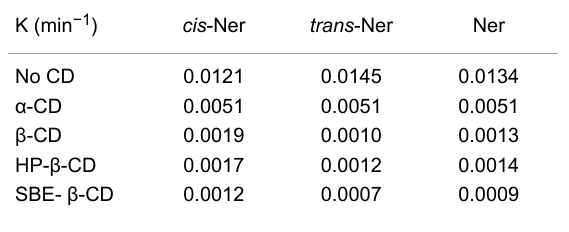
Table 4: Photodegradation rate constants ( K , min − 1 , Equation 5) of CD/Ner inclusion complexes upon UVB irradiation. K (min − 1